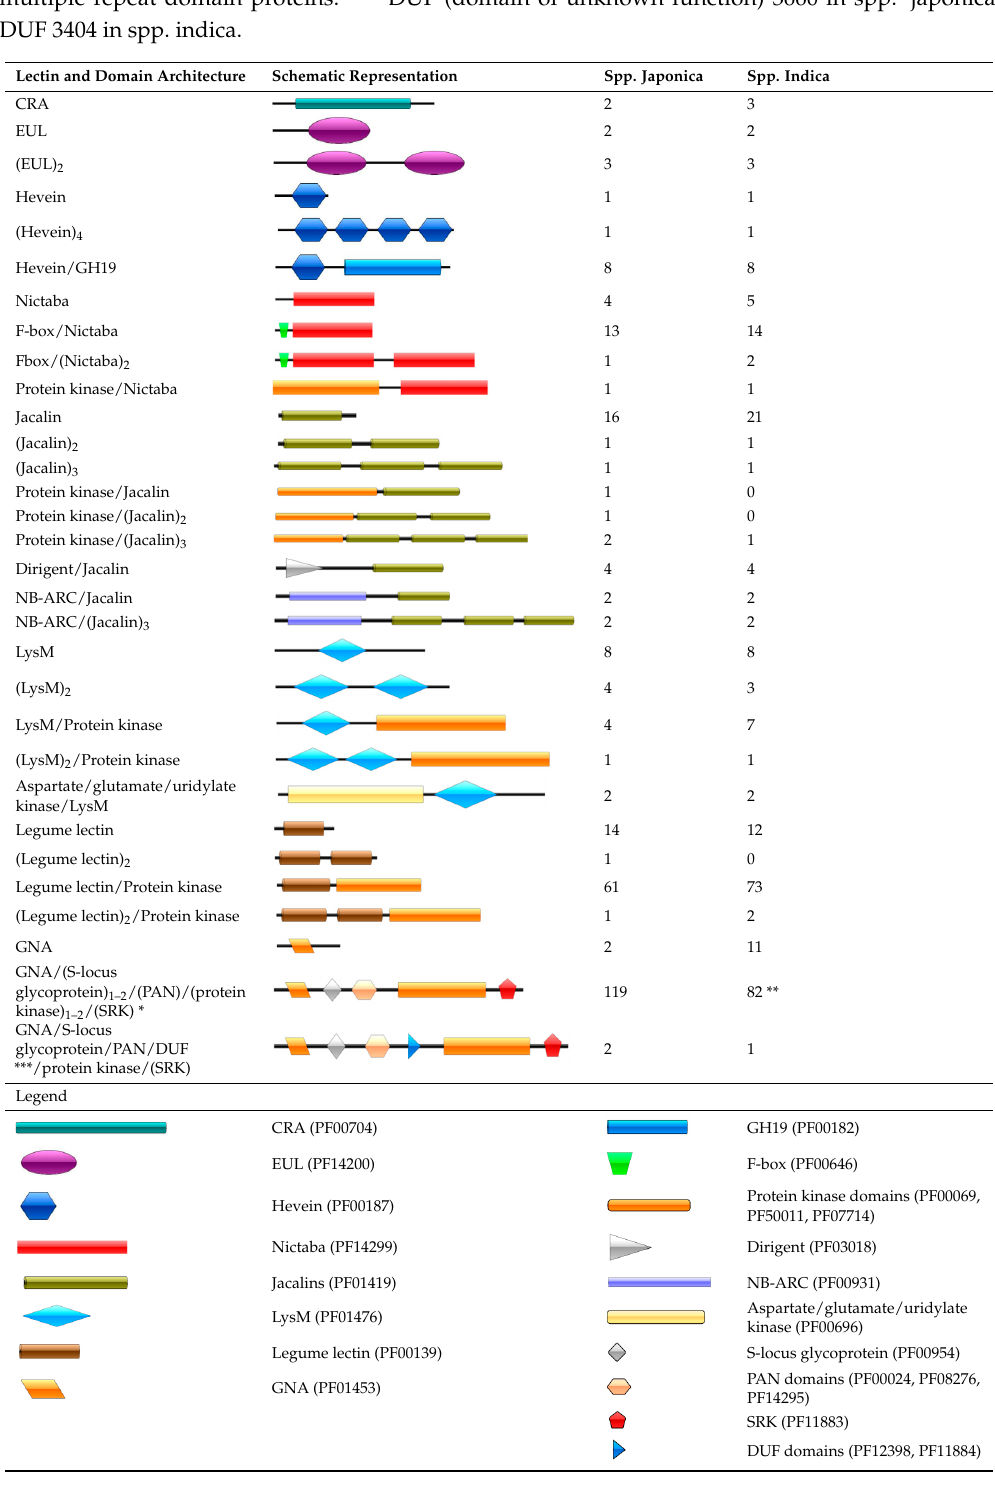
Table 1. Schematic representation of the shared domain architectures in O. sativa spp. japonica and indica. The numbering and domain organization for japonica is based on Rice Annotation Project Database (RAP-DB). * domain organization of the most representative combinations in the Galanthus nivalis agglutinin (GNA) family, see Supplementary Information, Table S3. ** includes also multiple repeat domain proteins. *** DUF (domain of unknown function) 3660 in spp. japonica, DUF 3404 in spp. indica.